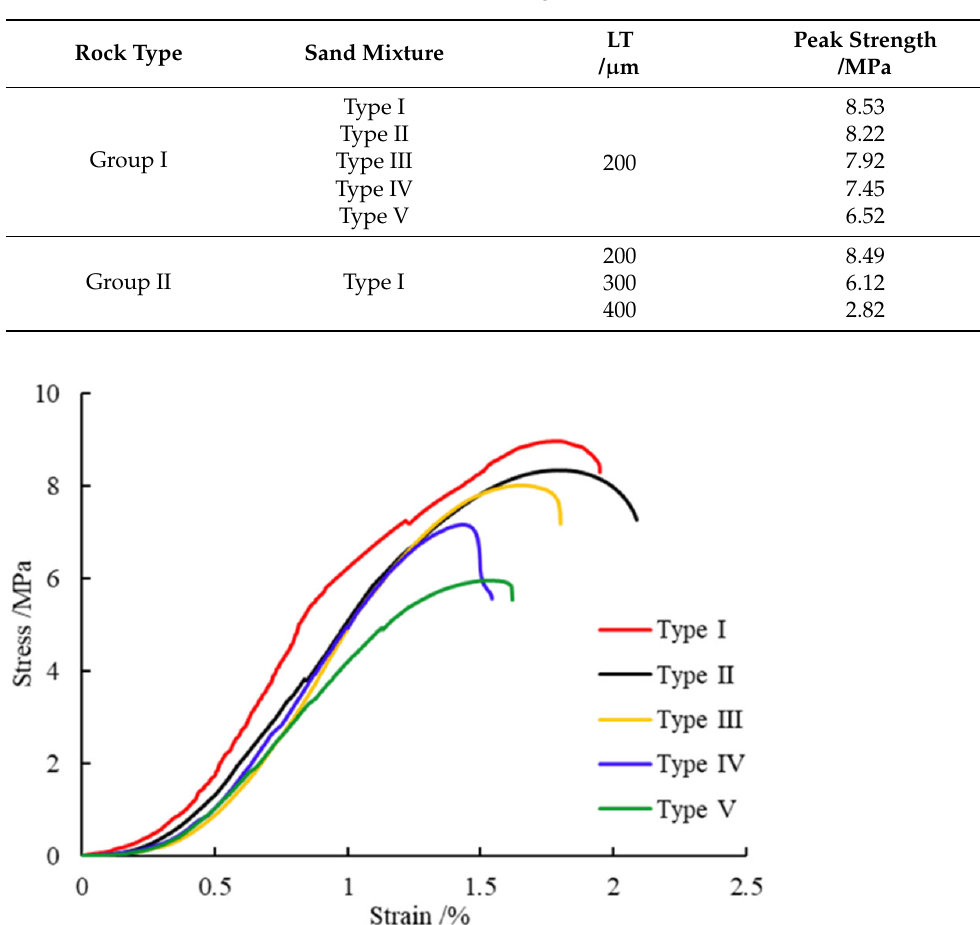
Table 3. Results of the UCS test on the 3DP rock analogs.